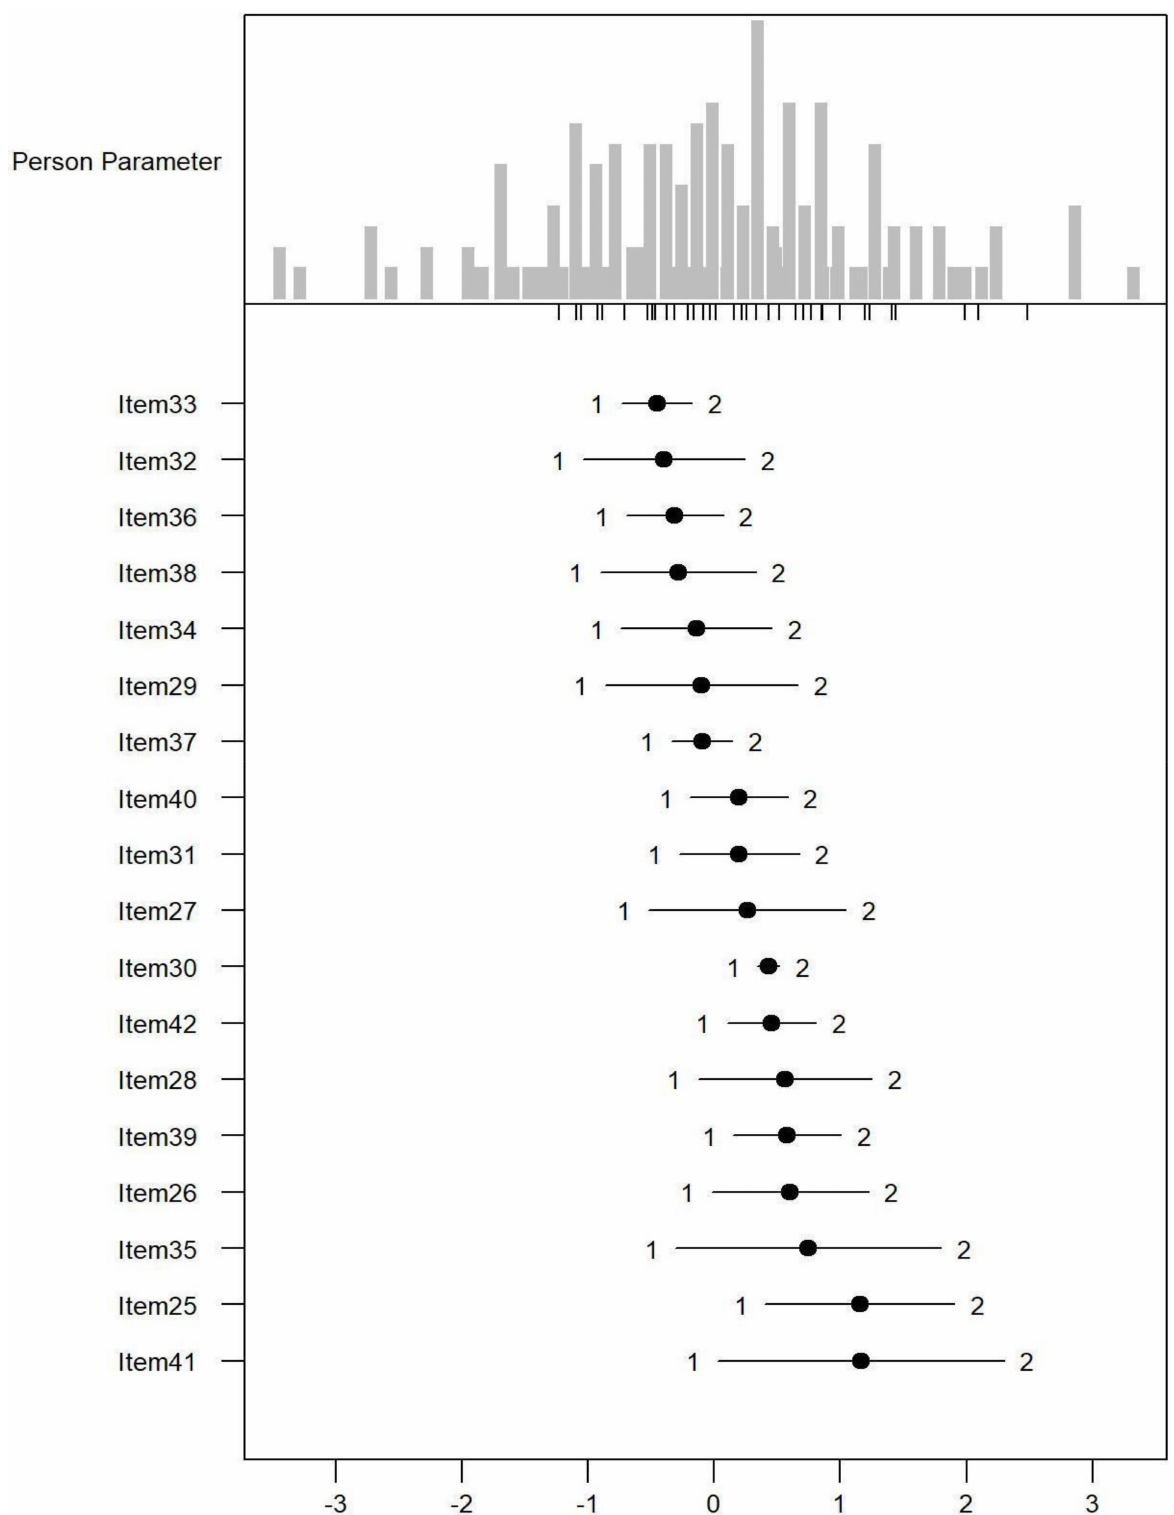
Figure 2. Person-item map for the person parameter and item parameter distribution of the 18 addi- tional Eden items having three response categories (1 = none, 2 = mild to moderate, and 3 = severe to extreme